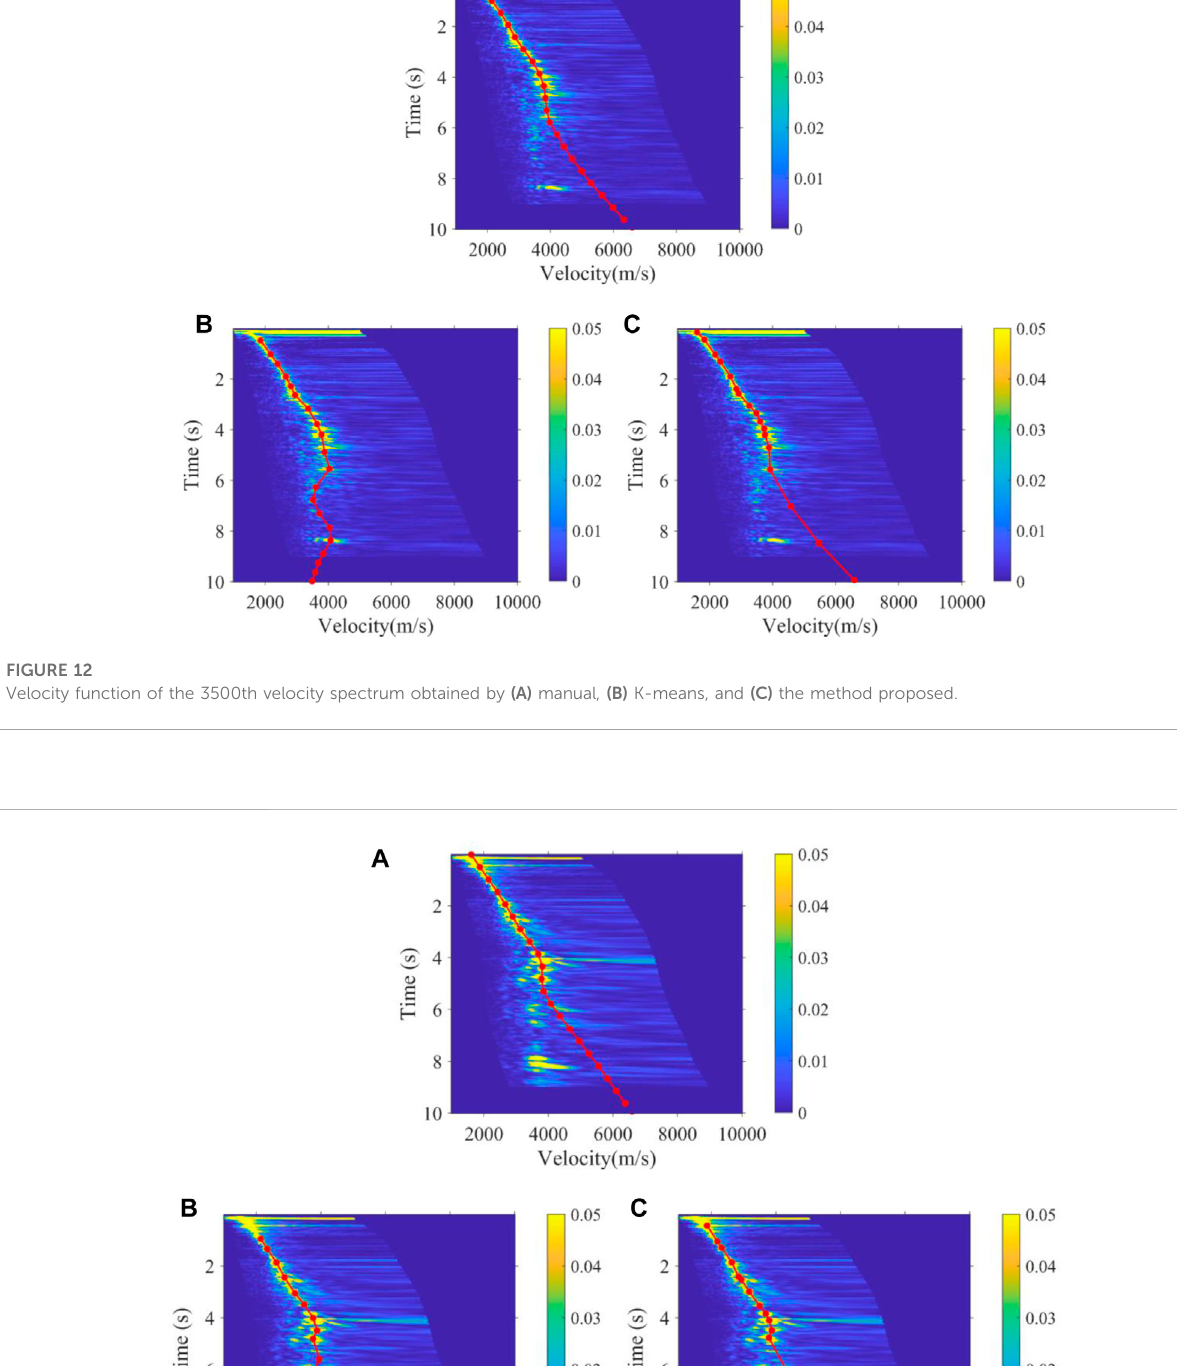
Frontiers in Earth